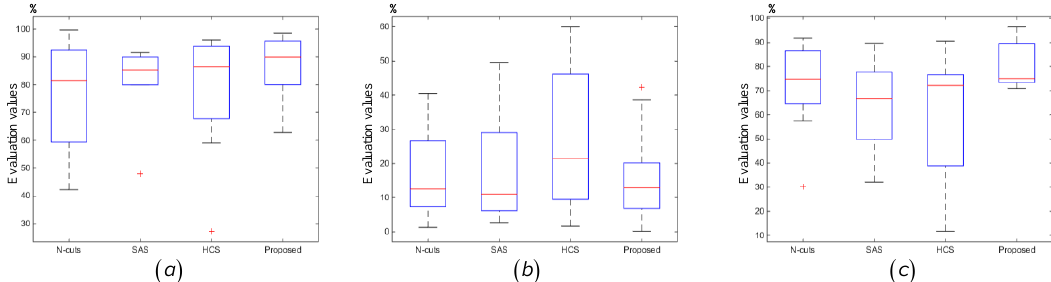
Figure 13. Comparative results of different algorithms. ( a ) Pixel accuracy (PA) experimental result; ( b ) relative limit measurement accuracy (RLMA) experimental result; ( c ) mean intersection over the union (MIoU) experimental result.